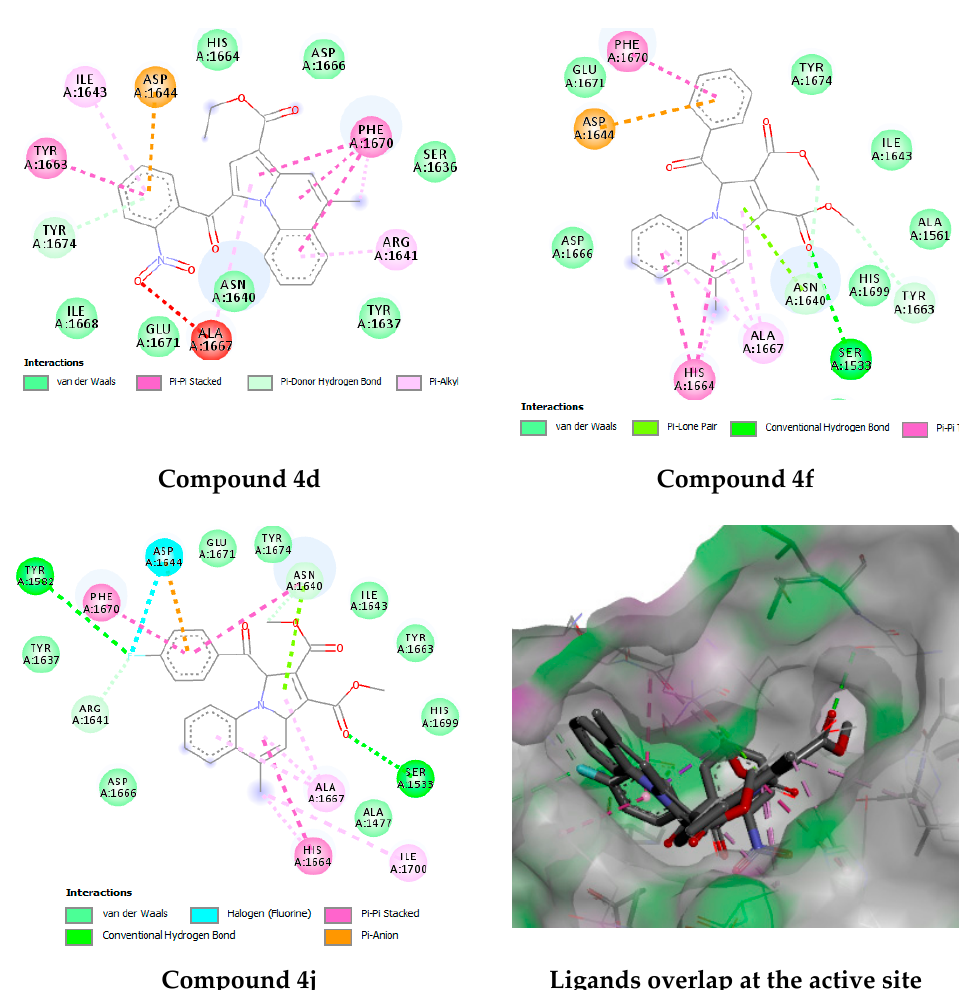
Figure 4. Intramolecular interactions of compounds 4d , 4f , and 4j with active site of Pks13 protein and their overlap at the active site.